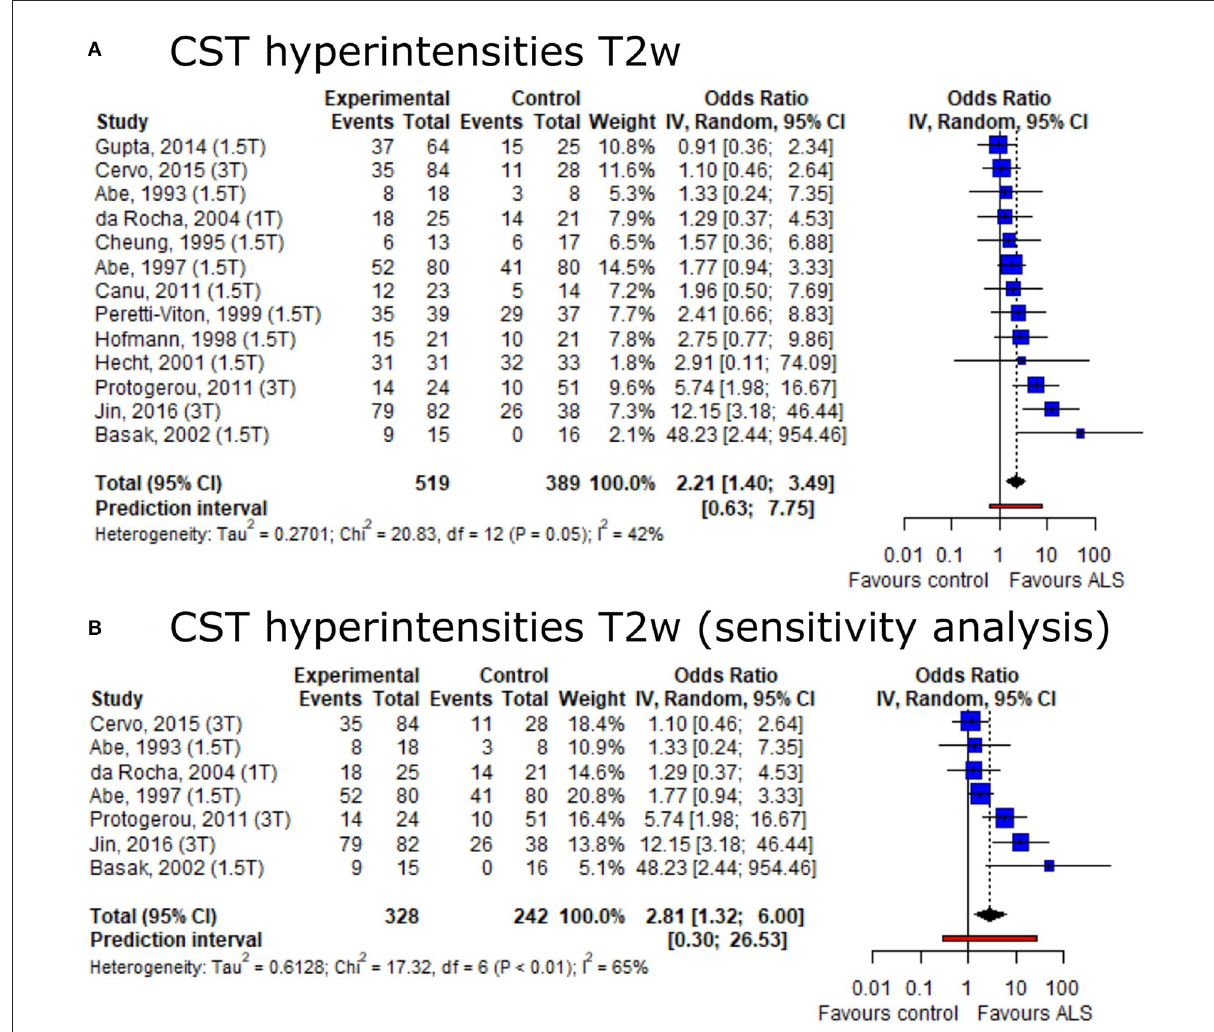
FIGURE3 Forest plot of corticospinal tract hyperintensities on T2w MRI odds ratios among ALS patients vs. controls. Pooled analyses of publications comparing odds ratios (OR) of corticospinal tract (CST) hyperintensities on T2w MRI in ALS patients and controls (A) and a sensitivity analysis only including publications with low risk of bias and comprising healthy controls (B) . Static magnetic field strength for MRI acquisition for respective publications are listed in brackets. Dotted line represents overall mean; black diamond represents overall confidence interval. CI, confidence interval; CST, corticospinal